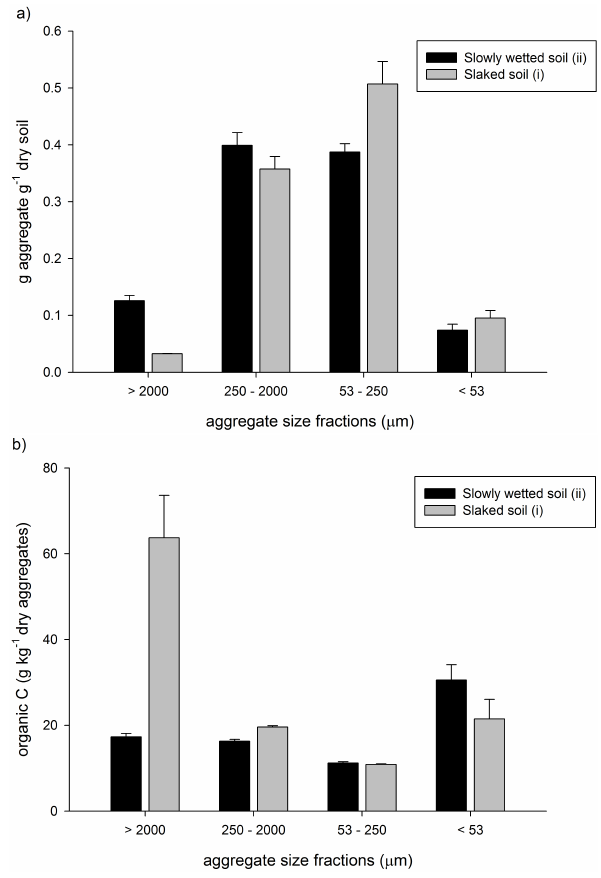
Fig. 4. (a) Aggregate-size distribution for slaked and slowly wetted soil. (b) Organic C concentration for the aggregate-size classes of the slaked and slowly wetted